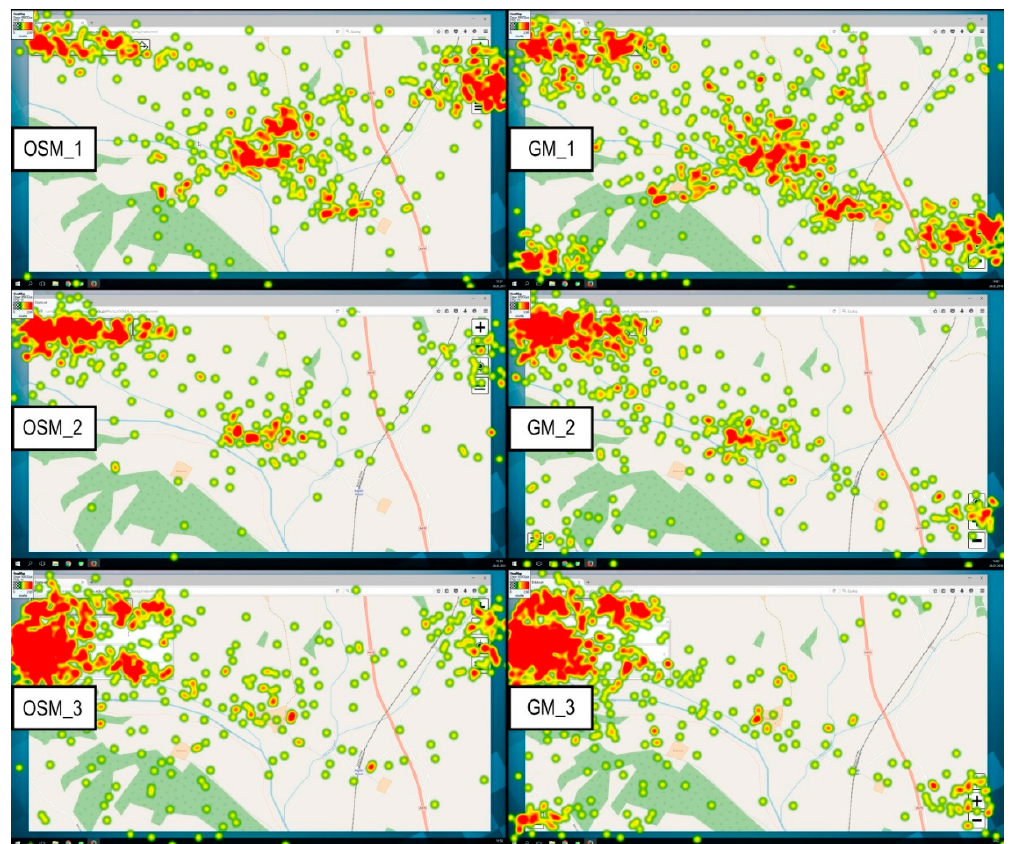
Figure 7. Six heatmaps presenting the spatial distribution of fixations in each task on both GUIs. OSM (from 1 to 3) stands for the OpenStreetMap-based GUI, and GM (from 1 to 3) stands for the Google Map-based GUI.